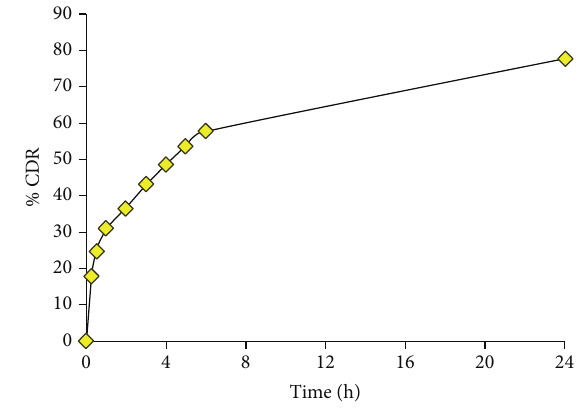
Figure 3: In vitro permeation study of patch. Table 7: Drug content of patch.